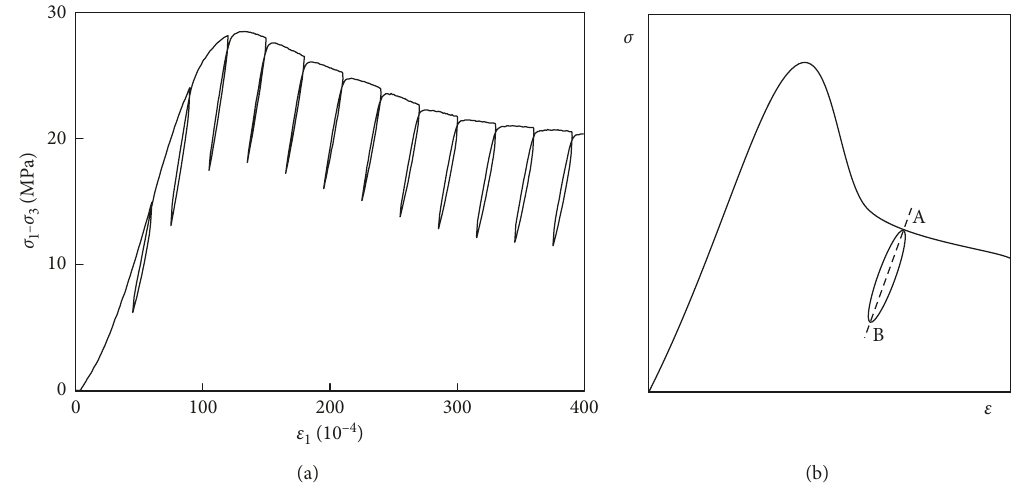
Figure 5: Calculation process of E d (a) stress-strain curve, (b) calculation